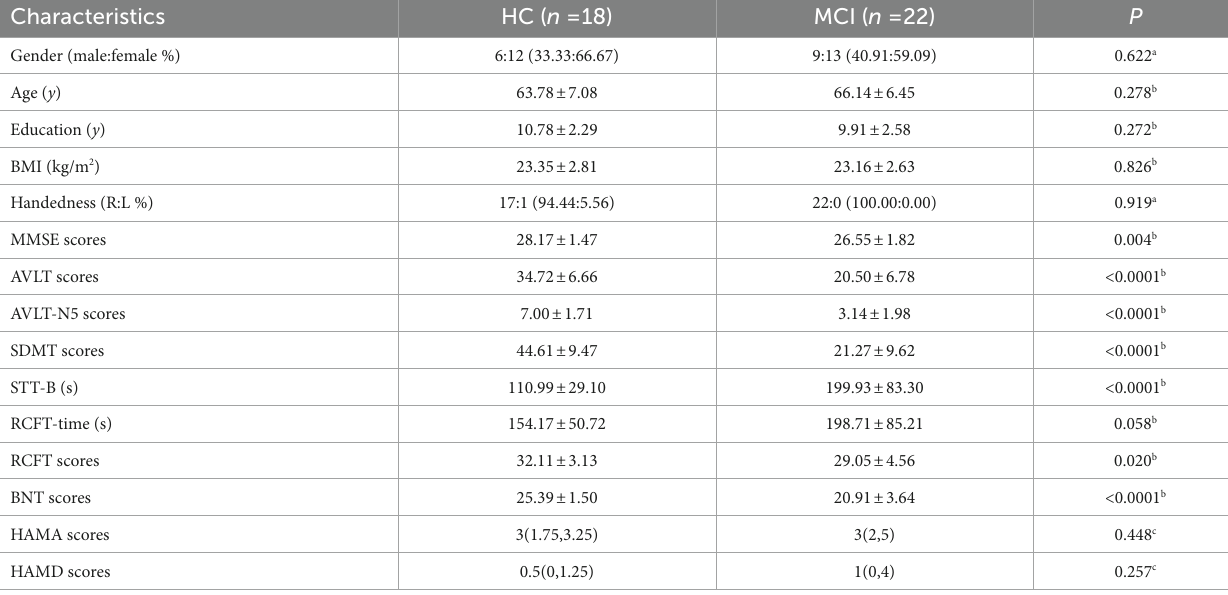
TABLE 1 Demographic and neuropsychological data of the MCI and HC groups.